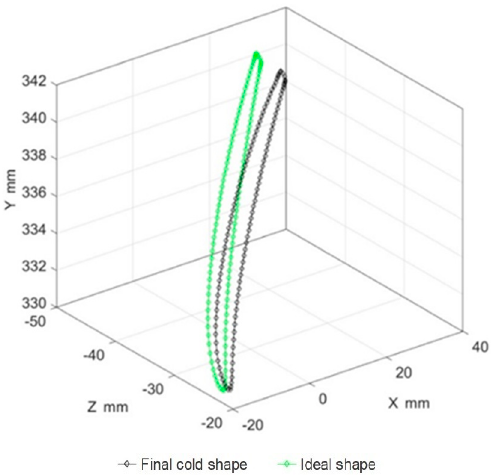
Figure 8. Positions of the contour nodes at the top of the cold blade shape.